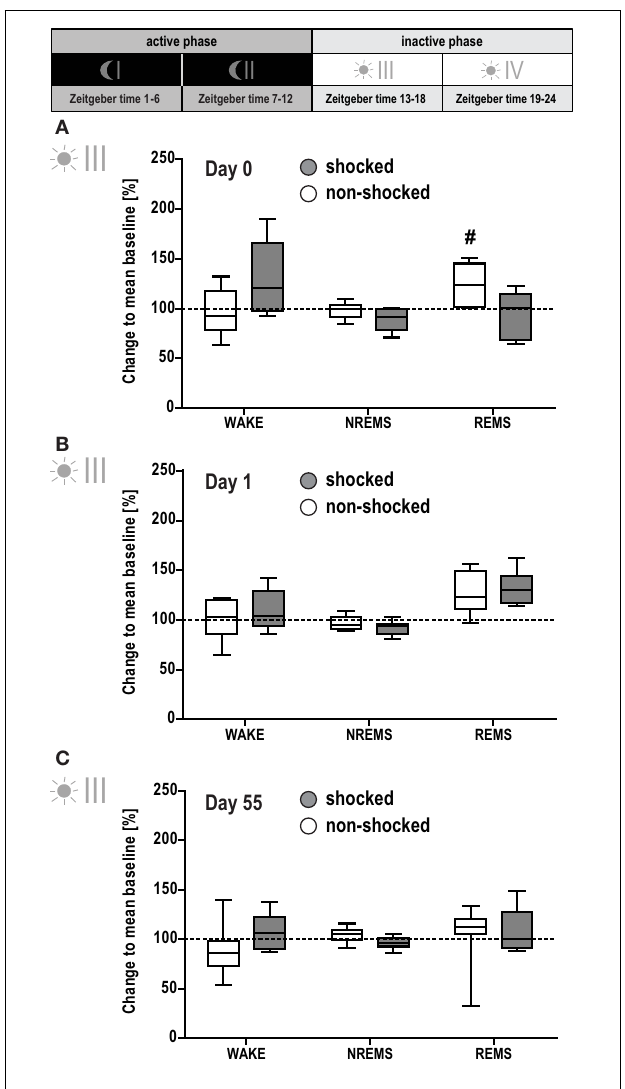
FIGURE 3 | Effect of shock on vigilance states during the first half of the inactive phase . Sleep-wake behavior of the shocked and non-shocked mice was recorded on the day of the shock [day 0, (A) ], the day after the shock [day 1, (B) ] and 2months after the shock [day 55, (C) ; for experimental schedule, see Figure 1A ]. For each recording day, results of the first half of the inactive (i.e., light) phase are depicted.The individual graphs show the change in time animals spent awake (WAKE), in non-rapid eye movement sleep (NREMS) or rapid eye movement sleep (REMS) relative to the group mean under baseline conditions (dotted horizontal line). Multivariate analysis revealed a significant group × day interaction effect on the conditioning day [day 0, A; group × day: F (9, 90) = 2.78, p < 0.01; day: F (9, 90) = 6.57, p < 0.001].This effect could be localized for REMS [group × day: F (3, 39) = 3.90, p < 0.02]. Controls showed an increased amount of REMS during phase III on day 0, i.e., after their exposure to the novel context [day 0 vs. baseline: F (1, 6) = 17.95, p < 0.008]. However, the comparison between groups did not reveal a statistically significant difference ( p < 0.05). Data are presented as box and whisker plots with boxes showing lower quartile, median and upper quartile, and whiskers showing the minimum and maximum sample. # p < 0.008 Indicates a statistically significant difference to baseline condition ( post hoc contrast tests in MANOVA; Bonferroni